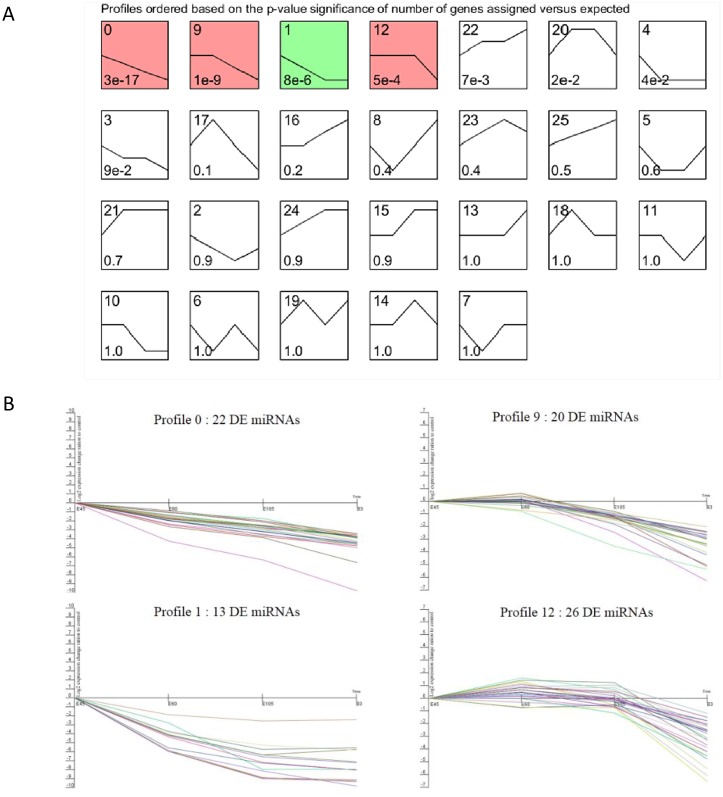
STEM analysis of the DE known miRNAs expression profiles.(A) Each box corresponds to a type expression profile and only colored profiles are statistically significant. The upper-left and bottom-left numbers in each box indicate the order of profiles and P-values, respectively. (B) Four significant clusters of miRNA profiles across all four stages.